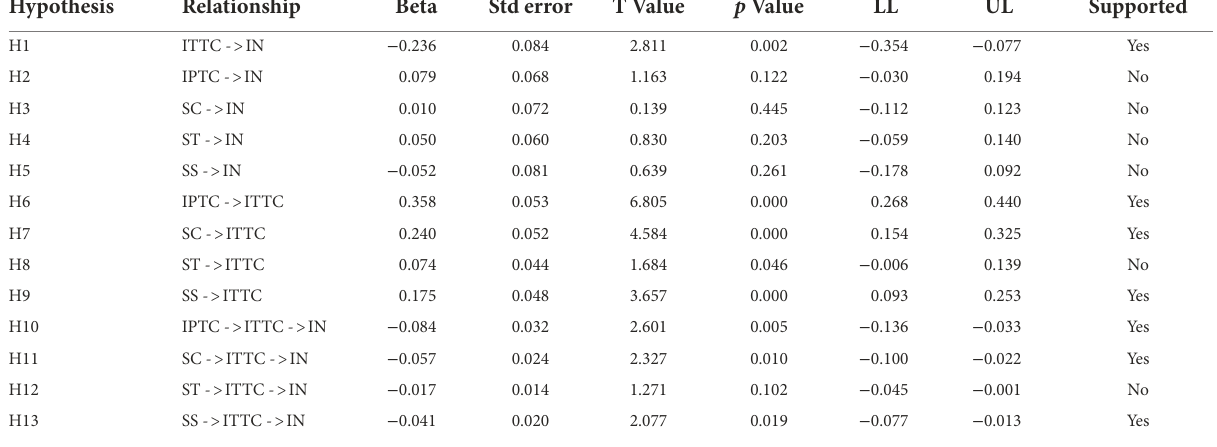
TABLE 6 Results of hypotheses testing. Hypothesis